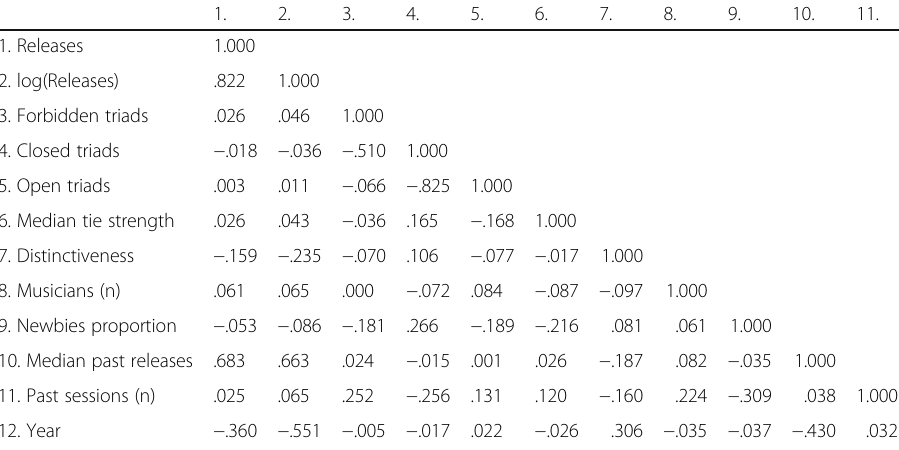
Table 4 Pearson correlation